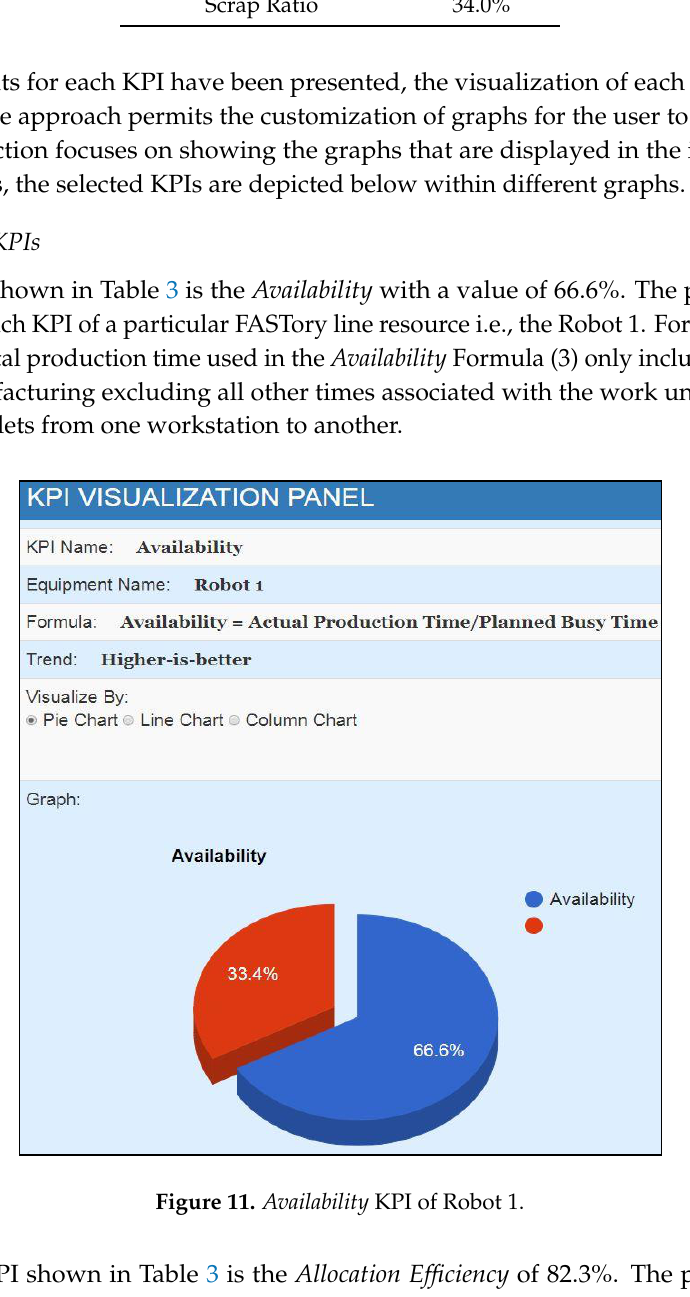
Figure 12. Allocation Efficiency KPI of Robot 1.